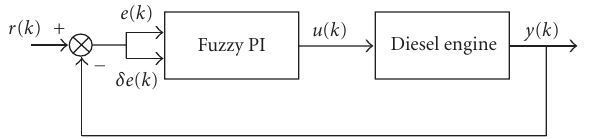
Figure 4: The structure of the control system with the proposed fuzzy PI